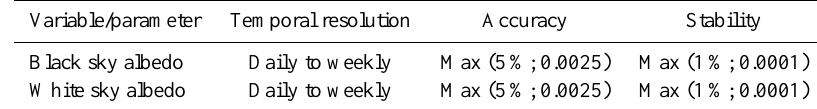
Table 1. Target requirements for the DHR and BHR iso defined in GCOS-154 (2011). Variable/parameter Temporal resolution Accuracy